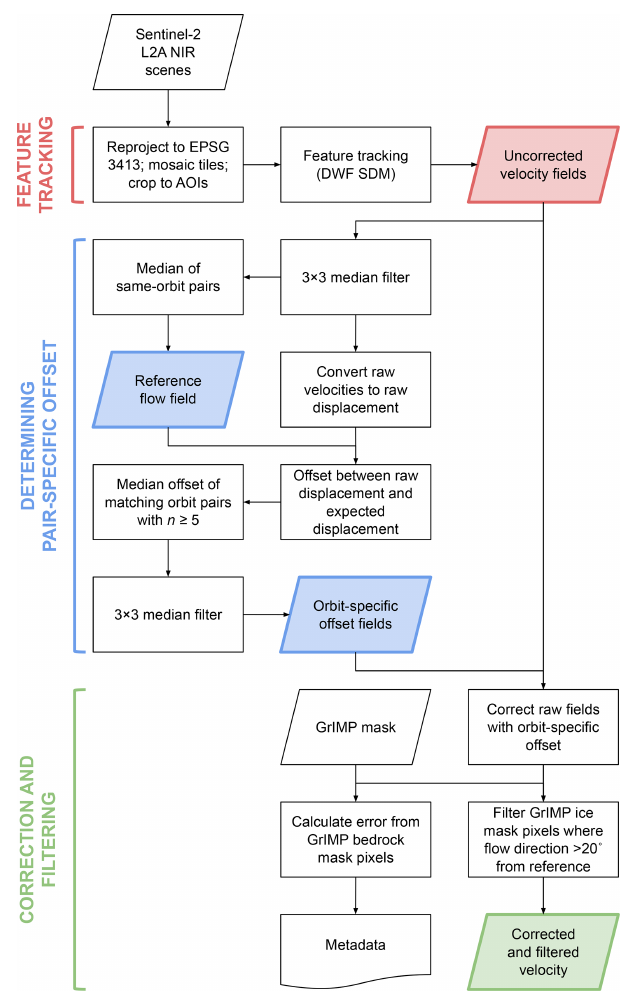
Figure 2. Workflow for deriving corrected and filtered glacier ve- locity fields from Sentinel-2 Level-2A